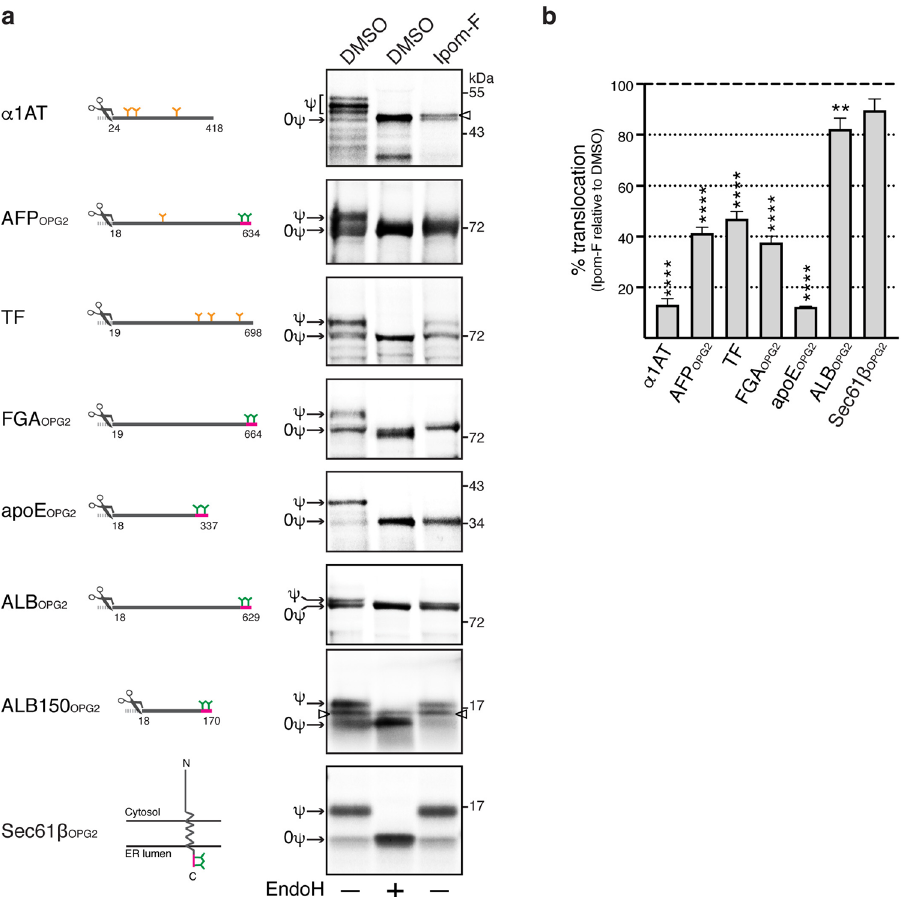
Figure 1. Ipom-F selectively inhibits the in vitro translocation of secretory Sec61 clients. ( a ) α1-antitrypsin (α1AT), serotransferrin (TF) and opsin-tagged variants of α-fetoprotein (AFP OPG2 ), fibrinogen α-chain (FGA OPG2 ), apolipoprotein E (apoE OPG2 ), serum albumin (full-length; ALB OPG2 , truncated; ALB150 OPG2 ) and Sec61β (Sec61β OPG2 ) were translated in rabbit reticulocyte lysate supplemented with [ 35 S]Met/Cys, canine rough microsomes and either DMSO or Ipom-F (1 μM). Membrane-associated products were isolated by ultracentrifugation, resolved by SDS-PAGE and analysed directly by phosphorimaging. Control samples were treated with endoglycosidase H (EndoH) to distinguish N-glycosylated (ψ) from non-glycosylated (0ψ) products. The position of a band most likely corresponding to the signal peptide (SP)-uncleaved precursor form of α1AT (see also Supplementary Fig. S1) and ALB150 OPG2 is indicated with an arrowhead. Representative phosphorimaging exposures are shown (full-length gels presented in Supplementary Fig. S5). Diagrams of constructs used are shown on the left. Numbers represent the corresponding amino acids of the preprotein. The cleavage site of N-terminal signal peptides (scissors symbol) and endogenous N-glycosylation sites (orange Y symbols) are indicated. Where indicated, a 17-amino acid reporter tag (depicted in red) derived from bovine opsin was appended to the C-terminus of proteins to introduce two exogenous N-glycosylation sites (green Y symbols). ( b ) Quantification of the population of in vitro translated substrates from ( a ) that was translocated across the ER membranes following treatment with Ipom-F. Translocation efficiency was determined from the ratio of N-glycosylated to non-glycosylated form for each precursor and expressed relative to the translocation efficiency in DMSO samples (set to 100%). Values are mean ± s.e.m from at least three independent experiments. ** P < 0.01; **** P < 0.0001 relative to DMSO (one-way